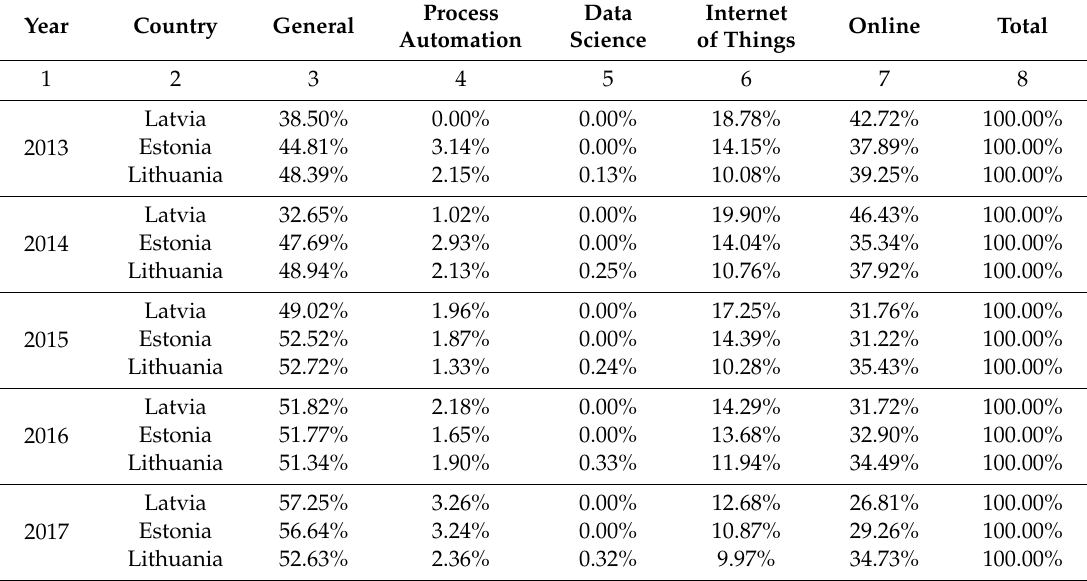
Table 1. Percentage share of digital maturity elements for Baltic States.